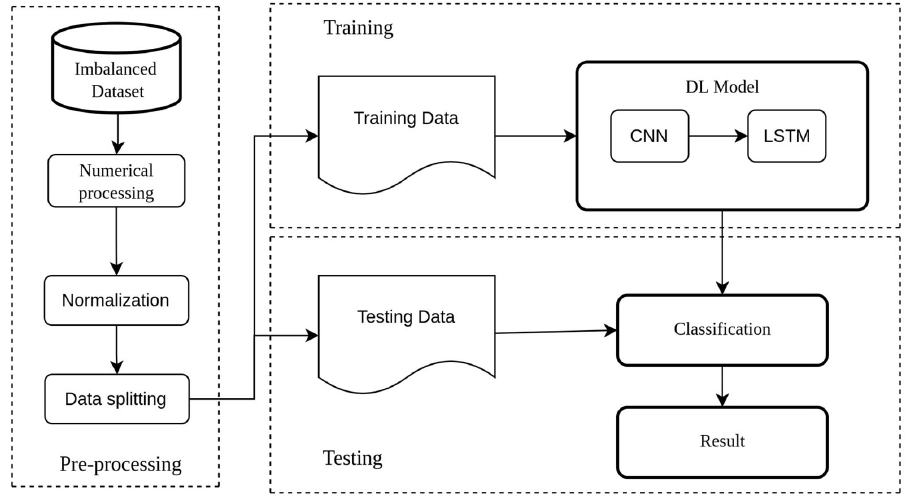
Figure 1. The flowchart of training the CNN-LSTM model with imbalanced data.